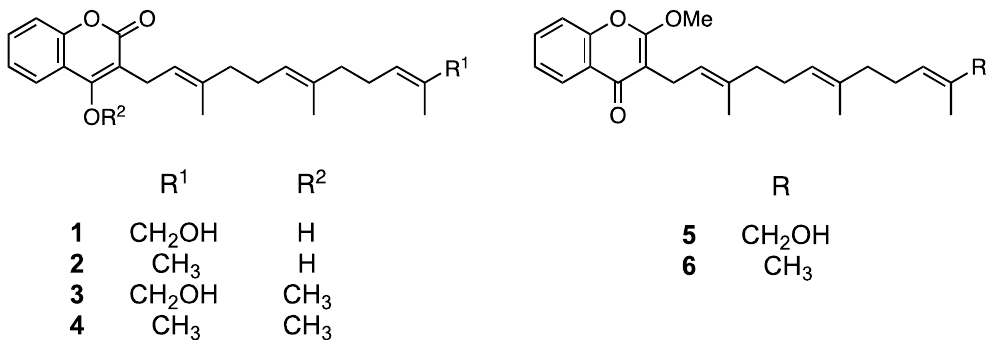
Figure 4. Chemical structures of 1 ( ω -hydroxyferulenol), 2 (ferulenol), and their methylated compounds ( 3 – 6 ). Compound 5 was obtained as an amorphous solid with the molecular formula C 25 H 32 O 4 ( m/z 397.2375 [M+H] + calculated for C 25 H 33 O 4 , 297.2379; Figure S8) according to an HR-ESIMS analysis, which is consistent with that of 3 . The 1 H NMR spectrum of 5 (Figure S9) was also similar to that of 3 ; however, the 13 C NMR spectra of both compounds differed in the low magnetic field region. Specifically, the chemical shift at δ 163.4 in the 13 C NMR spectrum of 3 shifted to δ 177.4 in the corresponding spectrum of 5 (Figure S10), which suggests the presence of a ketone in the latter compound and reveals the occurrence of a keto–enol tautomerization between both compounds, as shown in Figure 4. Accord- ingly, compound 5 was determined to be methylated ω -hydroxyferulenol containing a keto moiety in the coumarin skeleton (Figure 4).